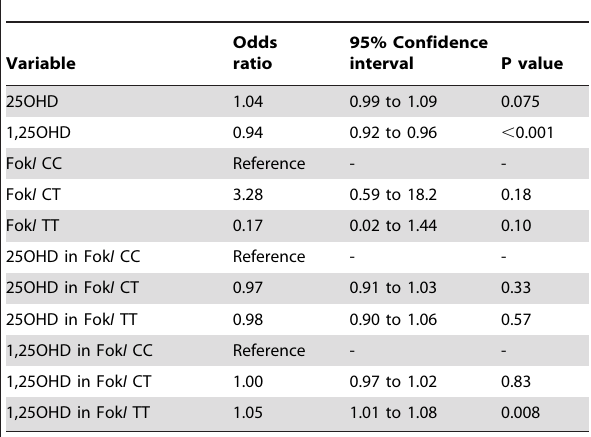
Table 2. Multiple ordered logistic regression model to see the interaction between Fok I genotypes and 25OHD/1,25OHD levels on eGFR stage adjusted with 7 possible confounders *